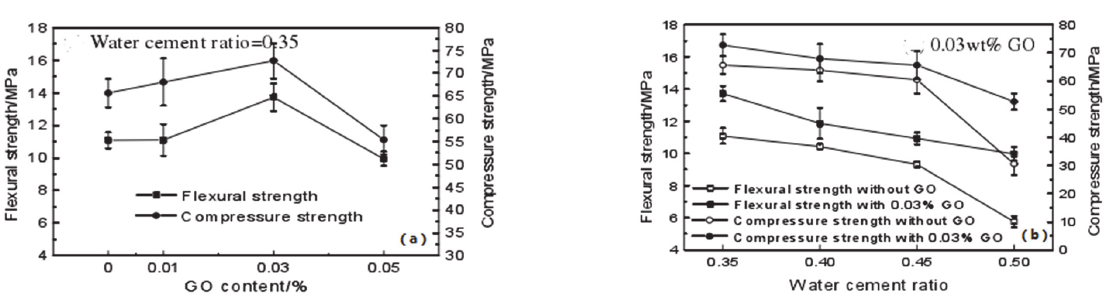
Table 3: The basic mechanical properties of cement mortar under different water cement ratios.